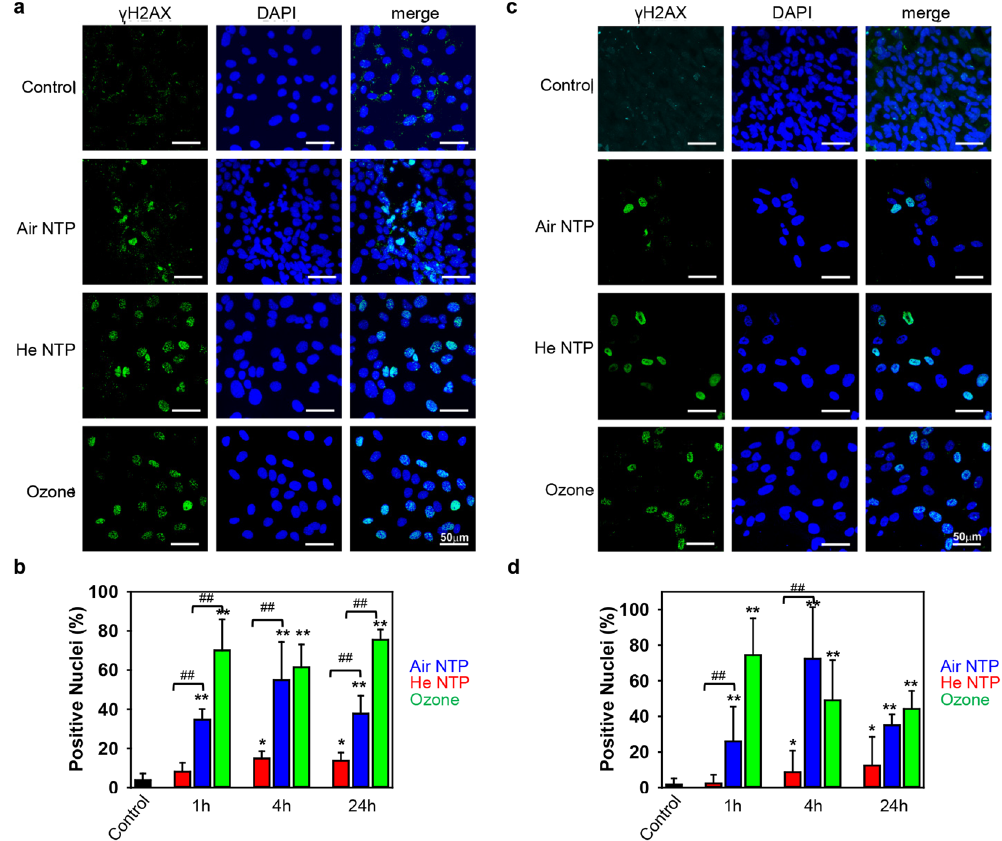
Figure 3. Induction of DNA damage by different NTPs and ozone. ( a ) 3T3 fibroblasts and ( c ) MSCs were treated with air, helium NTPs or ozone for 30 s, then 4 h after treatment cells were assessed by immunofluorescence utilizing an antibody to γ -H2AX (green) and nuclei (blue). ( b ) 3T3 fibroblasts and ( d ) MSCs treated with air, helium NTPs or ozone for 30 s. Cell were stained for nuclei (blue), and phosphorylated form of γ -H2AX (green) 1, 4 and 24 h post-treatment. Labeled cells were then imaged using epi-fluorescent microscopy. Quantitative analysis was carried out by counting the number of immunoreactive cells as the percentage of the total number of viable cells, as determined by DAPI staining. Image was processed and quantified with ImageJ software (NIH, Bethesda, MD, USA). Scale bar 50 µ m. * P < 0.05 ** P < 0.01 versus controls, ## P < 0.01, mean ± SEM, n =